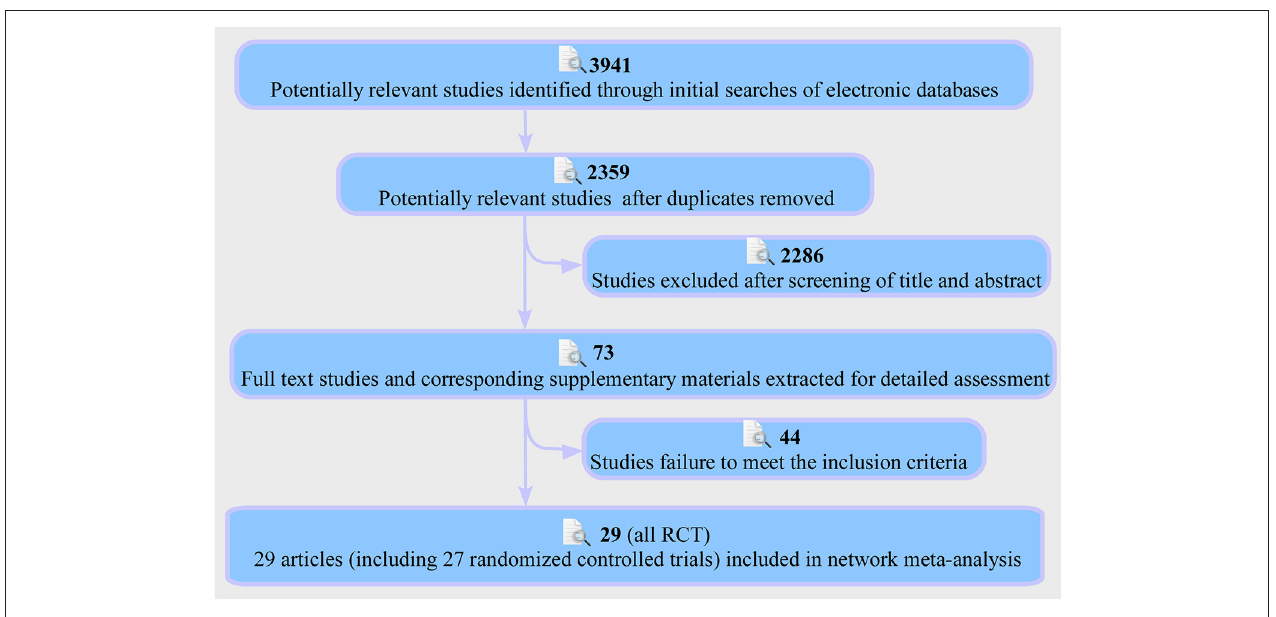
FIGURE 1 | Flowchart of study selection and